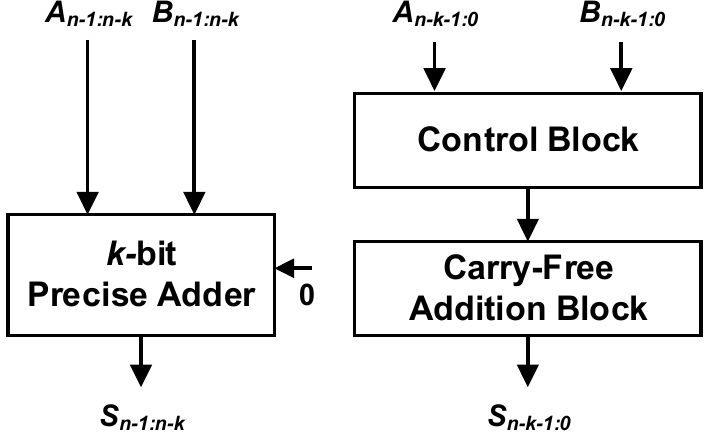
Figure 2. Architecture of error tolerant adder I (ETAI).